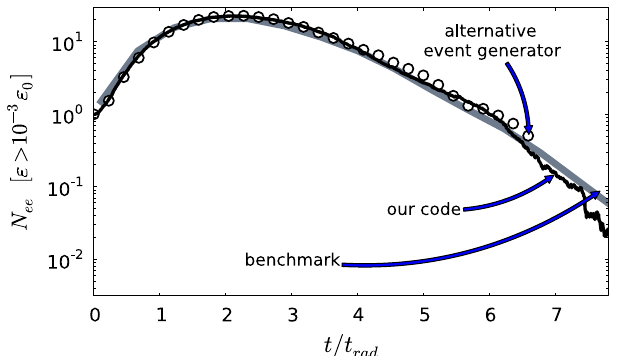
FIG. 3. Comparison of the cascade profile obtained with our code (black thin line), with a code applying an alternative event generator (circles) and from previous independent simulations (thick gray line, see Fig. 5 in [24]). Depicted is the number of pairs with energy " > 10 (cid:5) 3 " 0 versus the elapsed time. The simulation parameters are " 0 ¼ 100 GeV and E 0 =E S ¼ 0 : 2